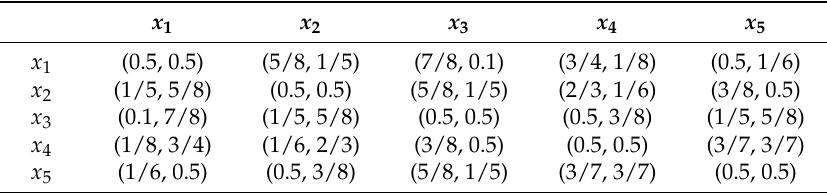
Table 2. Intuitionistic preference relation (cid:101) R ( 1 ) = ( (cid:101) r ij ( 1 ) )